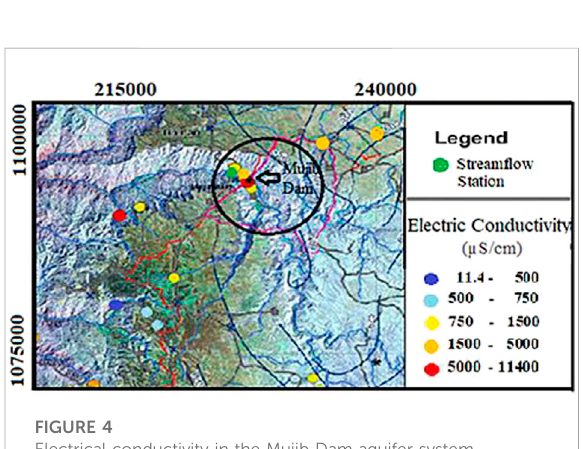
FIGURE 4 Electrical conductivity in the Mujib Dam aquifer